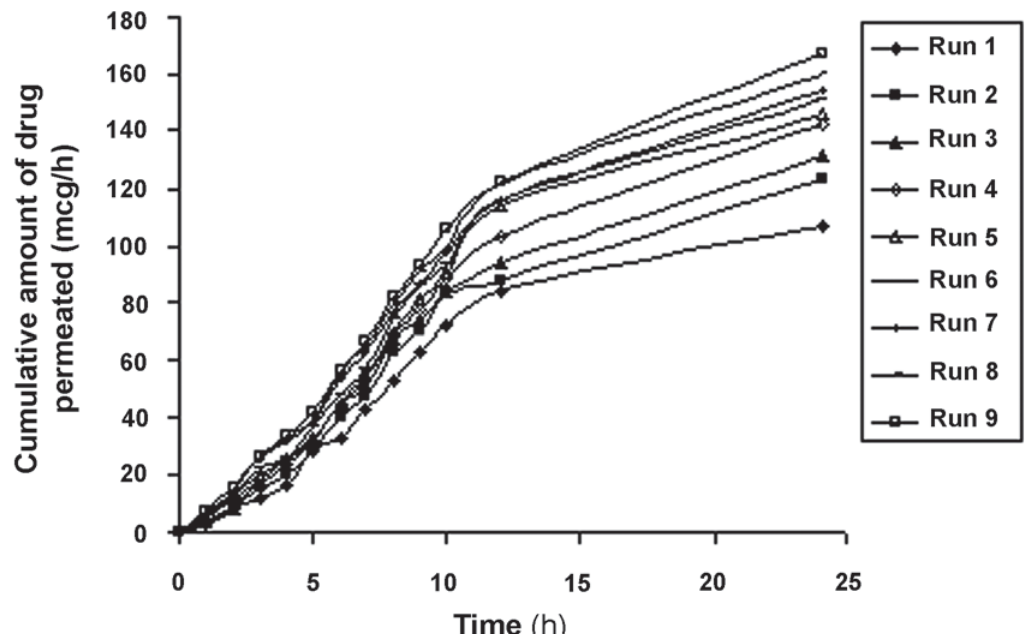
Figure 3 – In-vitro permeation profile of the factorial batches of alfuzosin hydrochloride transdermal films in normal saline as diffu- sion media.